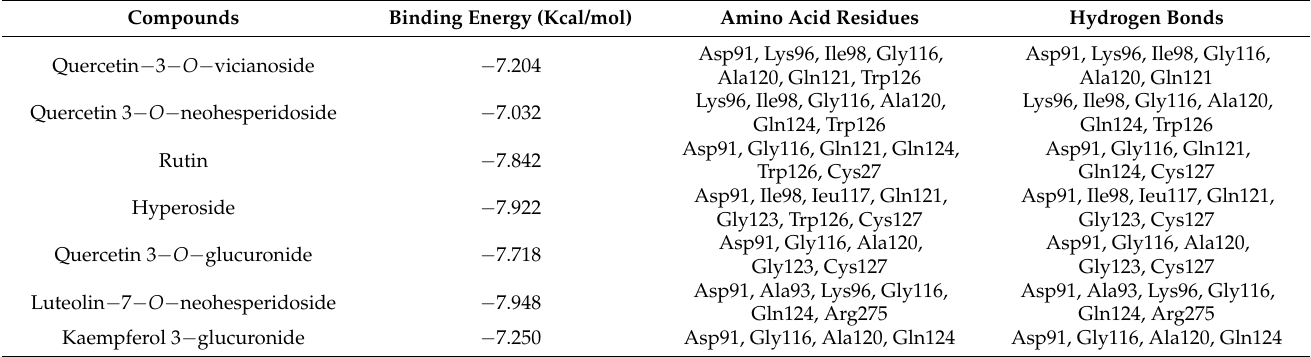
Table 3. The molecular docking analysis of